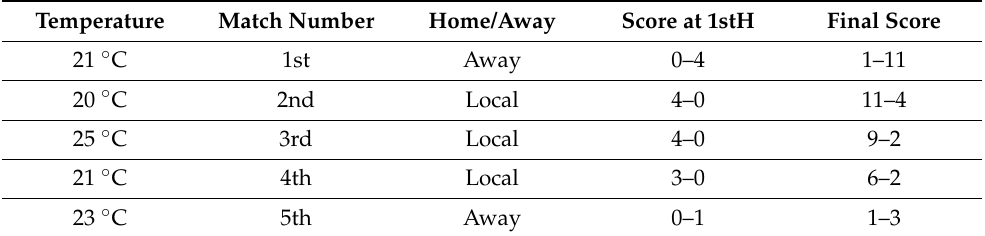
Table 3. Descriptive characteristics derived from each official